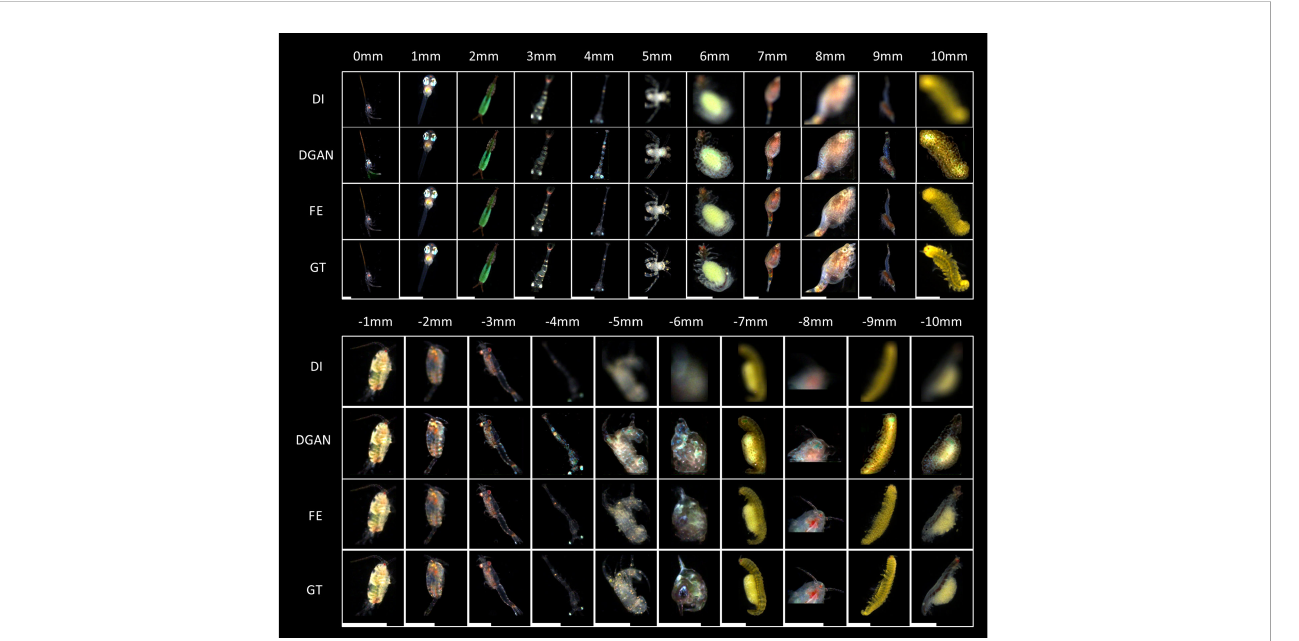
FIGURE 5 Visual comparisons of the focus-extension performances of two DNNs on representative marine plankton images. DI, DGAN, FE and GT represents the defocused images as network input, their corresponding restored images by the DeblurGAN-v2 and IsPlanktonFE models, and the focused ground truth images, respectively. The value above each column indicates the defocus distance label of the DI relative to the GT images. The length of the scale bars at the bottom is 1mm. The abbreviations of DI, FE, GT and DGAN are also applicable to other fi gures in this